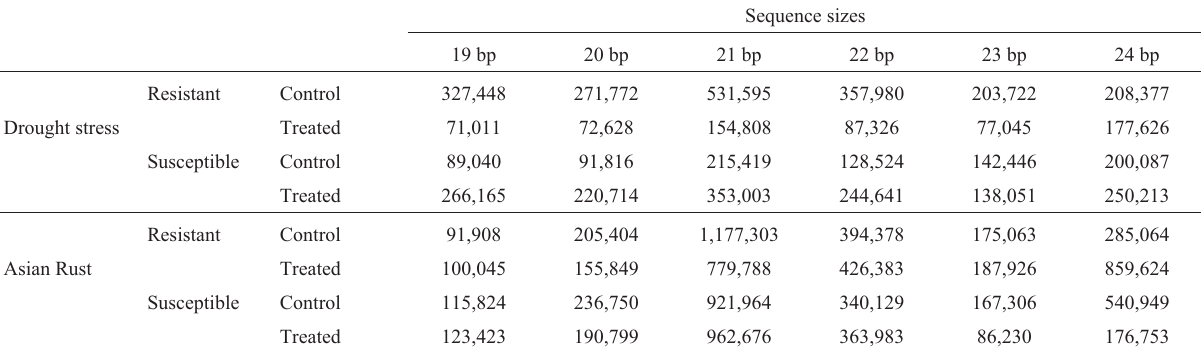
Table 3 - Data from Solexa MicroRNA libraries deposited in the Genosoja databank.